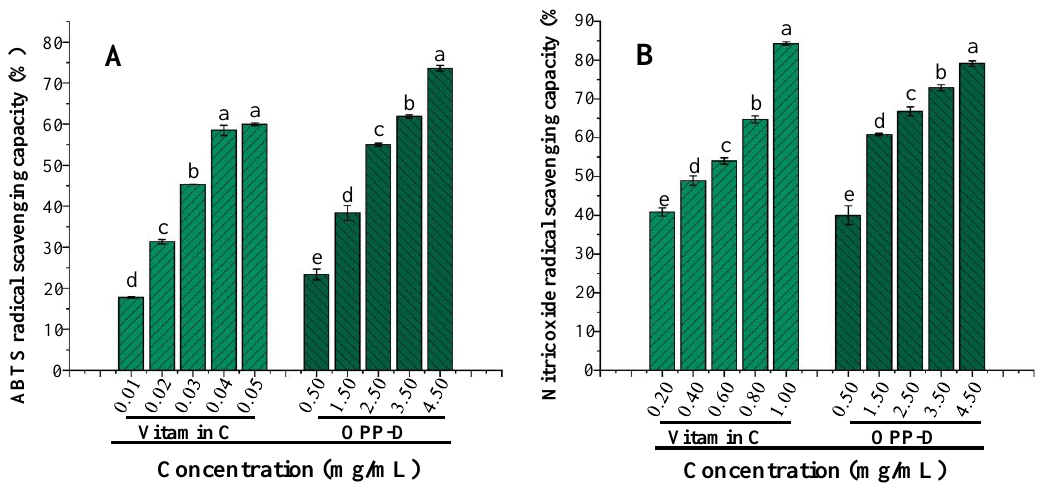
Figure 6. 2,2′ -Azino-bis (3-ethylbenzthiazoline-6-sulphonic acid) ABTS radical cation scavenging activity ( A ) and nitric oxide radical scavenging activity ( B ) of OPP-D. The error bars are standard deviations. Significant ( p < 0.05) differences are shown by data bearing different letters (a – e). Statistical significances were carried out by ANOVA and Duncan’s test.